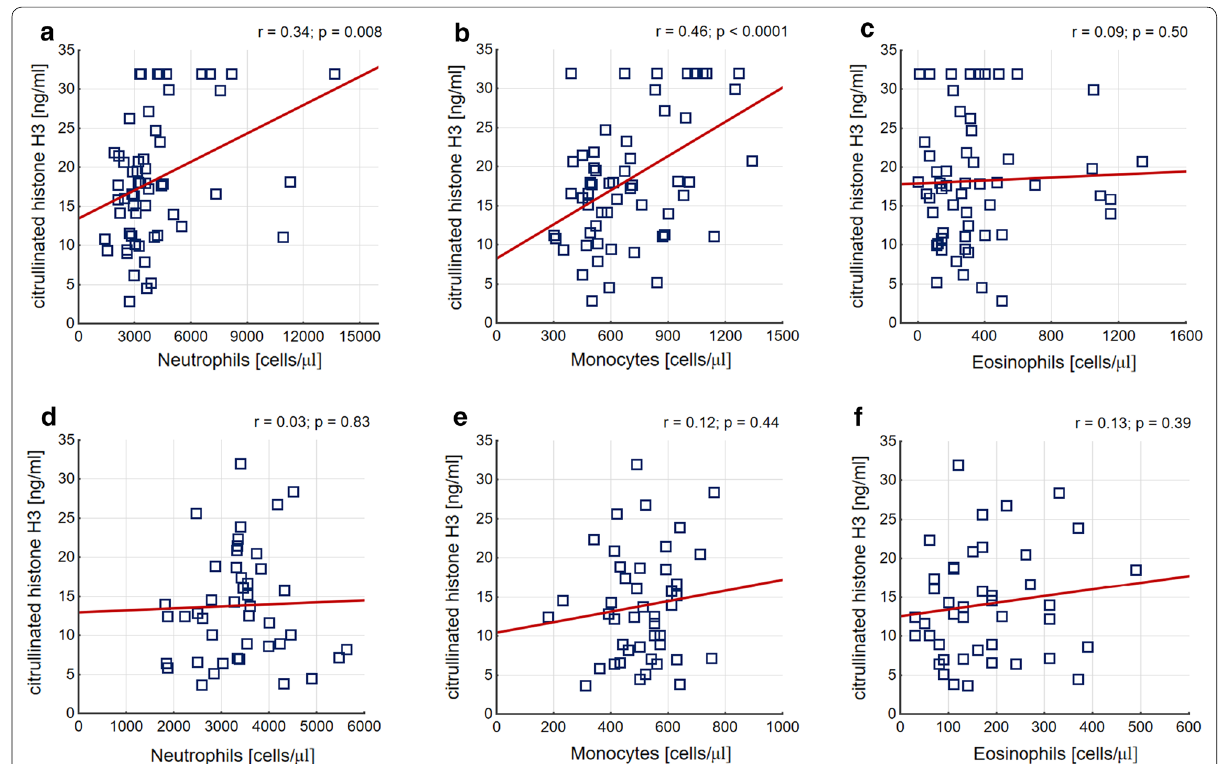
Fig. 2 Correlations between peripheral blood cell counts and serum H3cit concentration. a – c Present correlations in asthma patients. d – f Present correlations in controls. Pearsons’s correlation coefficients with p‑values were calculated and are shown in the panels